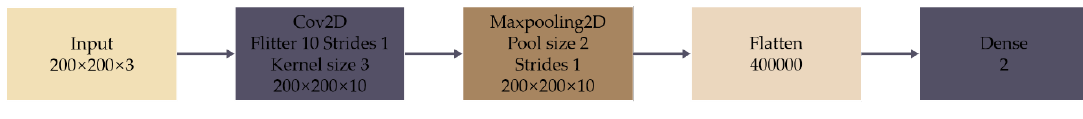
Figure 9. Structure of glance network constructed by NAS.